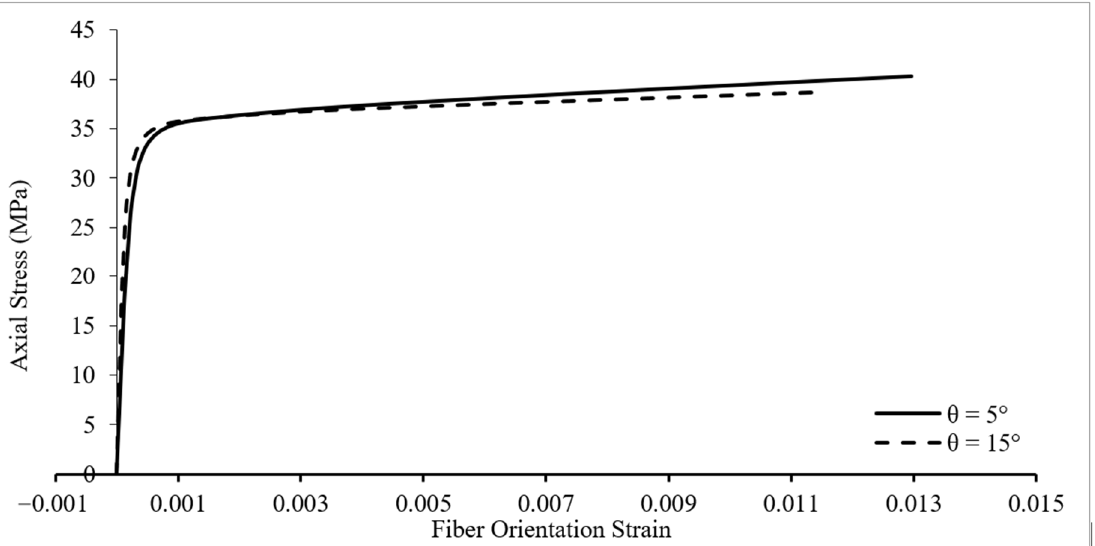
Figure 6. Variation of axial stress–fiber orientation strain of specimen C2E1T1 for different fiber orientations.